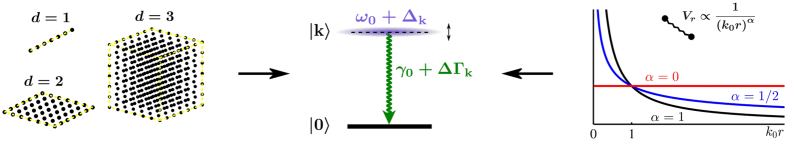
Design of an artificial optical transition through tailored superradiance.A d-dimensional lattice of atoms is embedded into an electromagnetic reservoir that mediates an inter-atomic coupling Vr ∝ 1/rα, where atoms are separated by a distance r and the coefficient α characterises the distance-dependence (see equation (2)). We show that the resulting collective eigenstates can be utilised for the implementation of an artificial transition with tunable decay rate and transition frequency.